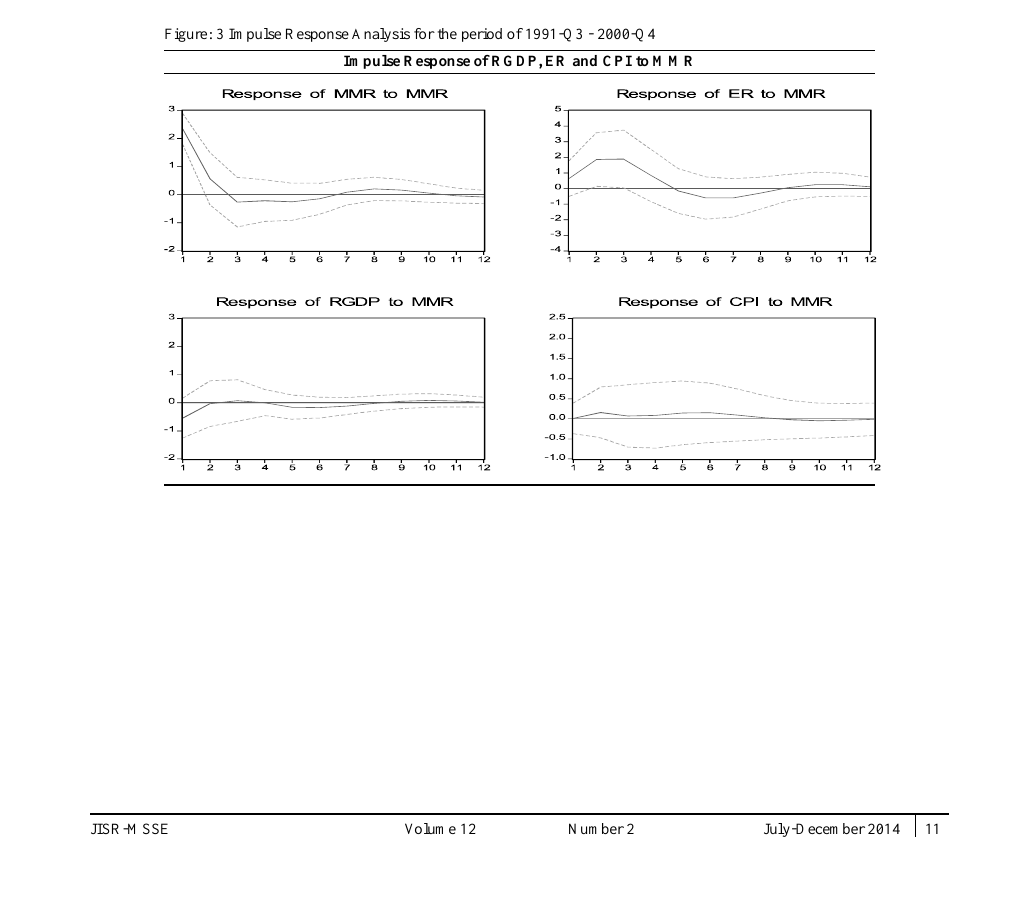
Figure: 3 Impulse ResponseAnalysis for the period of 1991-Q3 - 2000-Q4 Impulse Response of RGDP, ER and CPI to